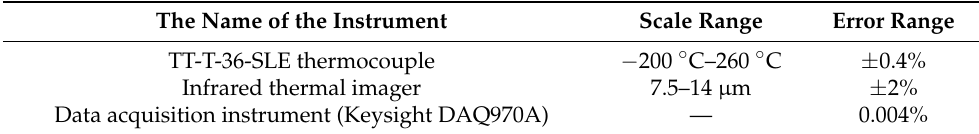
Table 3. Parameters of experimental